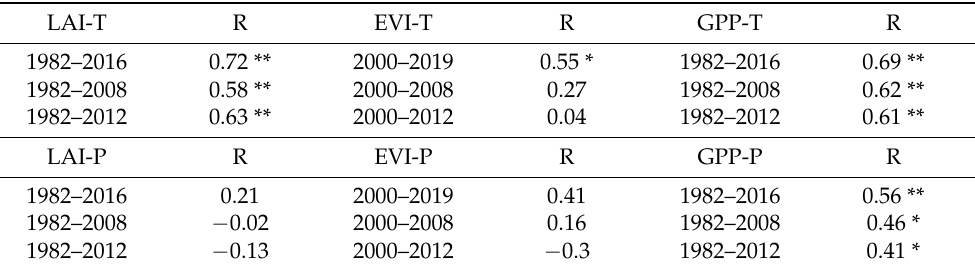
Figure 11. Recovery of vegetation after drought events: I—most of the vegetation was restored; II—only partial vegetation was restored; and III—very little vegetation was restored. Table 3. Partial correlation between temperature, precipitation, and vegetation indicators in three